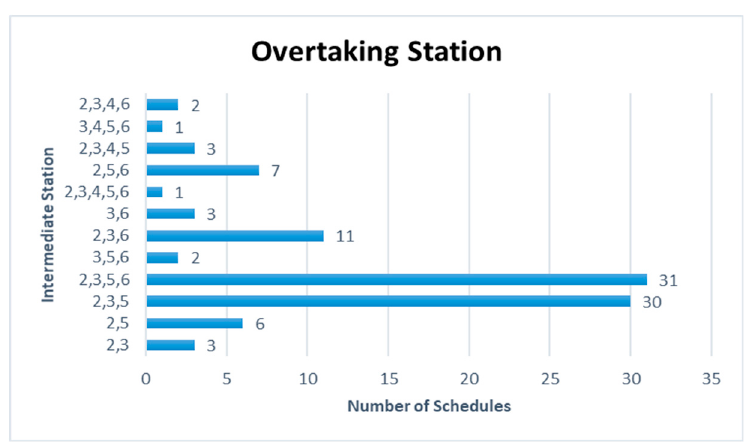
Figure 21. Overtaking Station for Case 5.